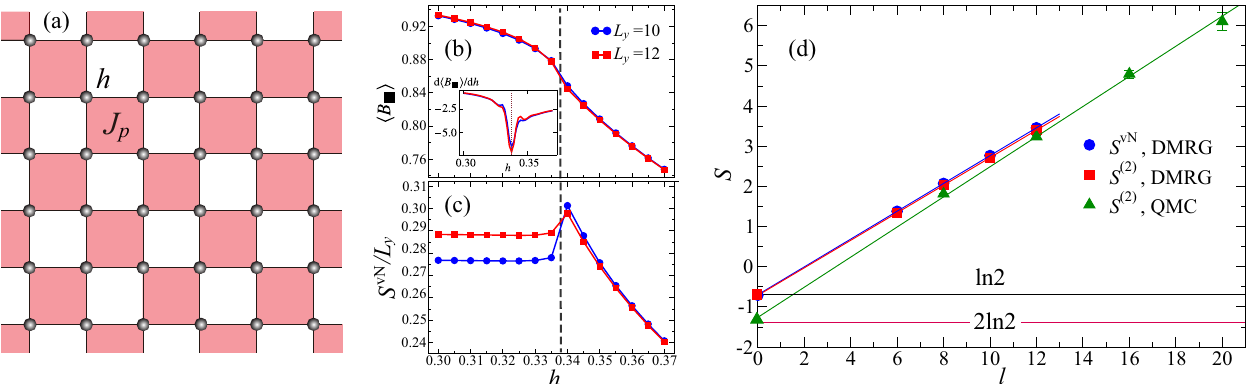
Fig. 3 Results of TEE for toy model. a The checkerboard lattice Z 2 gauge fi eld model with plaquette term B ◼ and transverse fi eld h term as in Eq. (3). b , c The DMRG results on the plaquette energy term and the von Neumann entropy for cylinder geometry with L x = 72 and L y = 10 and 12. The decon fi ne-con fi ne transition happens at h c = 0.33, indicating by the vertical dashed line, which is determined by the dip of the slope d 〉 /d h for both circumferences. c The EE at h = 0.3 < h 〈 B ◼ c of von Neumann and 2nd Rényi obtained from DMRG with 72 × 12 cylinders and the QMC measurements on torus of size L × L with L = 4, 6, 8, 10. d The entangling region A for QMC is L × L /2 (similar with Fig. 4b and the boundary length l = 2 L . The extrapolation for both DMRG and QMC gives rise to the TEE of values γ = 0.69(1) for cylinder geometry and 2 γ = 1.35(8) for torus geometry, respectively. SEM is used when estimating the errors of the physical Q σ z with B ’ (cid:4) and ■ being the red-colored plaquettes in i i 2 ’ Fig. 3a. Note that this Hamiltonian has an extensive number of conserved quantities: